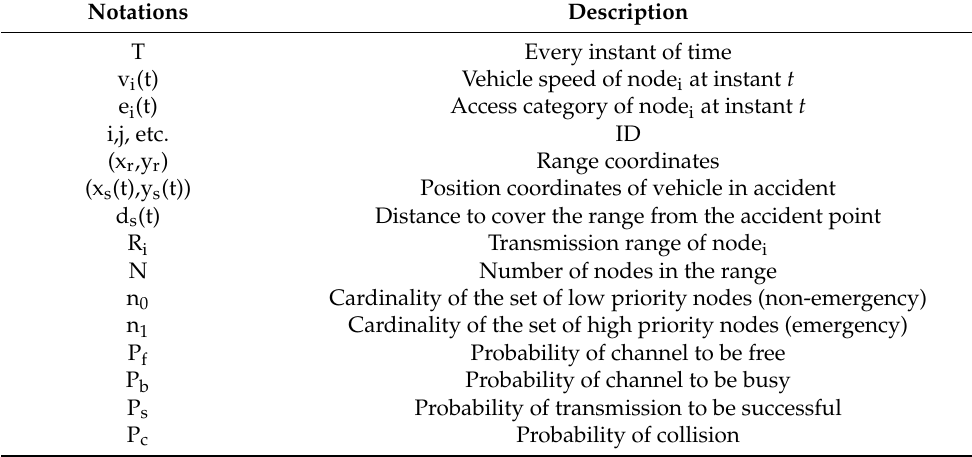
Figure 7. Flow of execution of the proposed protocol. The notations used in the protocol are represented in Table 3. Table 3. Notations and descriptions used in